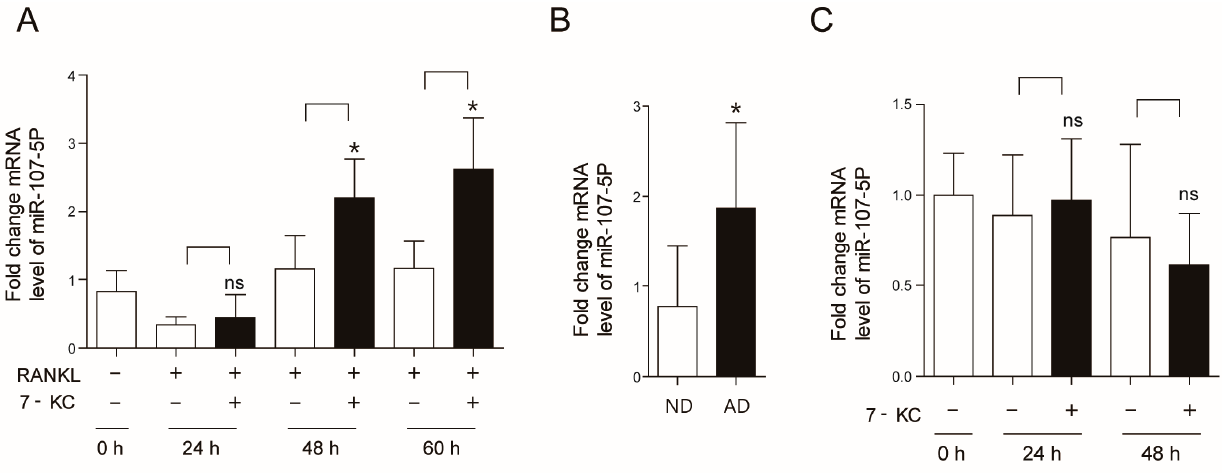
Figure 1. Atherogenic diet (AD) upregulates micro-RNA-107-5p (miR-107-5p). ( A ) Bone marrow- derived macrophages (BMMs) were prepared and incubated with or without 7-ketocholesterol (7-KC, 7 μ M) in the presence of macrophage colony stimulating factor (M-CSF, 30 ng/mL) and receptor activator of nuclear factor kappa-B ligand (RANKL, 40 ng/mL) for the indicated times, and then analyzed by qPCR to quantify the expression of miR-107-5p (n = 3–5). ( B ) Tibiae from mice fed with an AD or normal diet (ND) for 12 weeks were analyzed by qPCR to quantify the expression of miR-107-5p (AD, n = 8; ND, n = 8). ( C ) Primary osteoblasts were treated with 7-KC (7 µ M) for the indicated time points and analyzed by qPCR to quantify miR-107-5p expression (n = 4). * p < 0.05 compared with each corresponding group; ns, not significant. Similar results were obtained in three independent experiments.